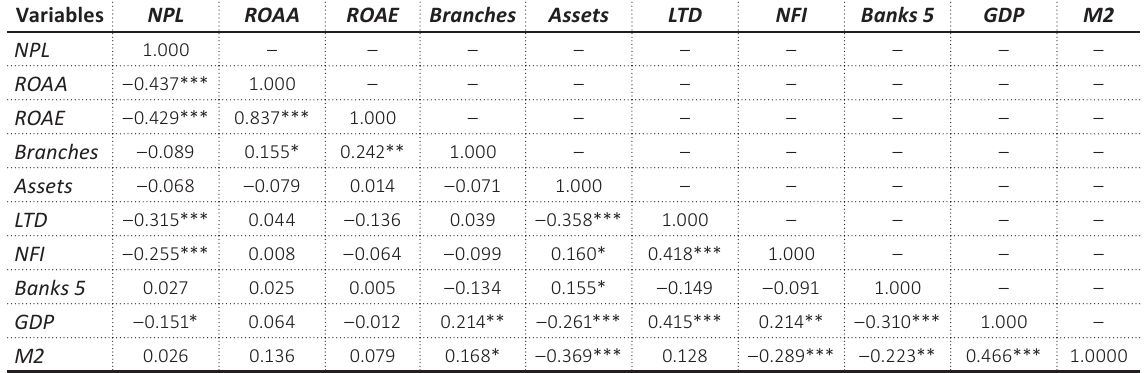
Table 3. The correlation